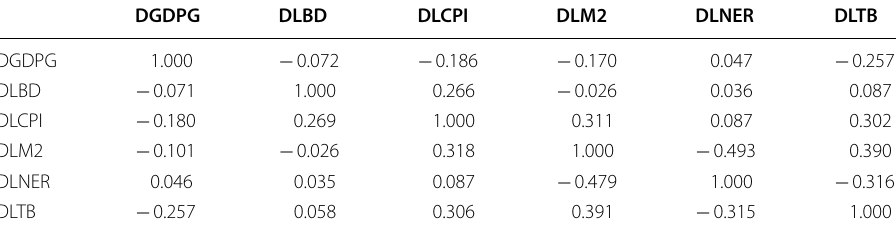
Table 2 Unit root test results in levels Variable ADF-statistic P value* Phillips Perron statistic P value* LBD LCPI LNER LTB LM2 *Significant at 1%, **Significant at 5%, ***Significant at 10%